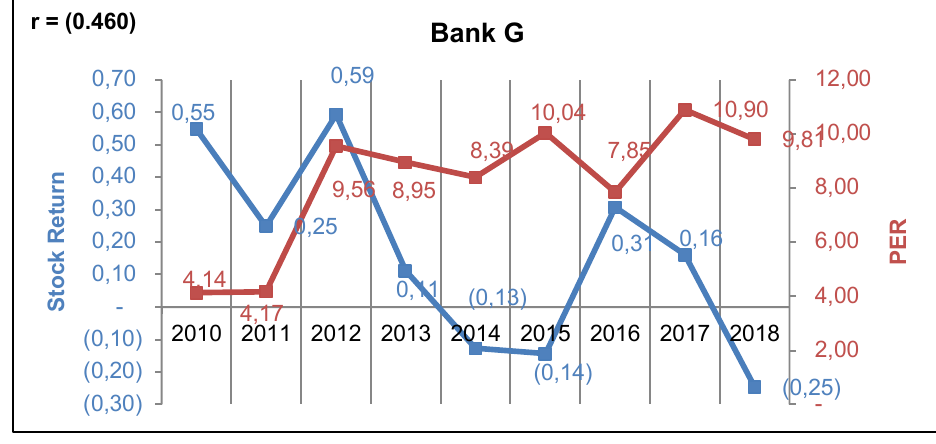
Figure 7: For Bank G